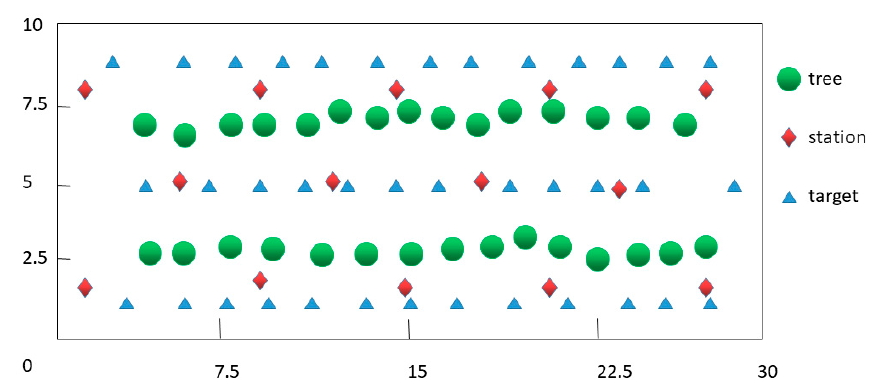
Figure 4. Experimental setup and scanning data collection: the sample plots were scanned using a terrestrial laser scanner (TLS), and scanners were placed on each side and lateral position to ensure full coverage of the target trees.